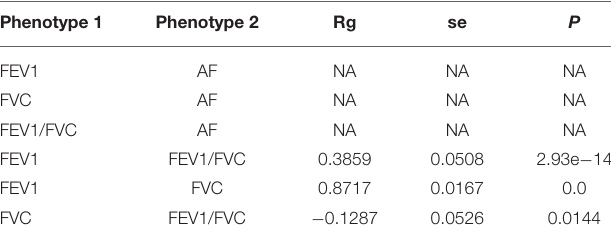
TABLE 1 | Genetic Correlation estimates from LDSC